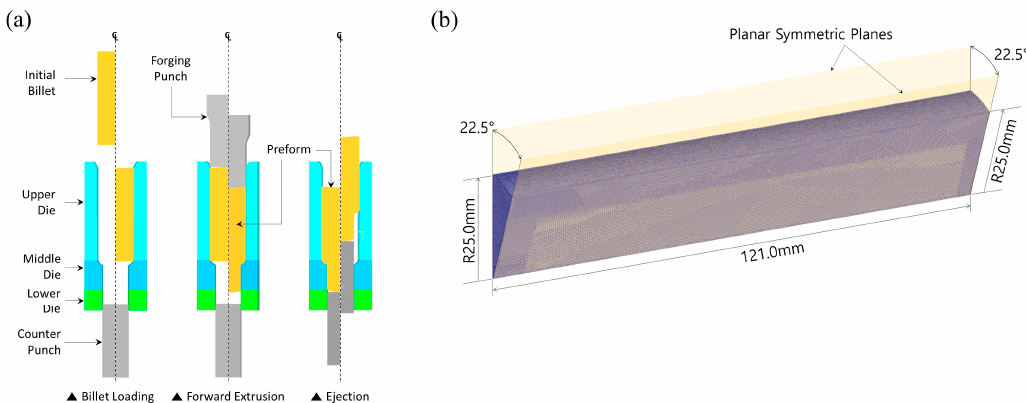
Figure 7. ( a ) FE simulation flow of cold forward extrusion for shaping preform, and ( b ) discretized mesh structure of initial billet with one-sixteenth planar symmetric condition. mesh structure of initial billet with one-sixteenth planar symmetric